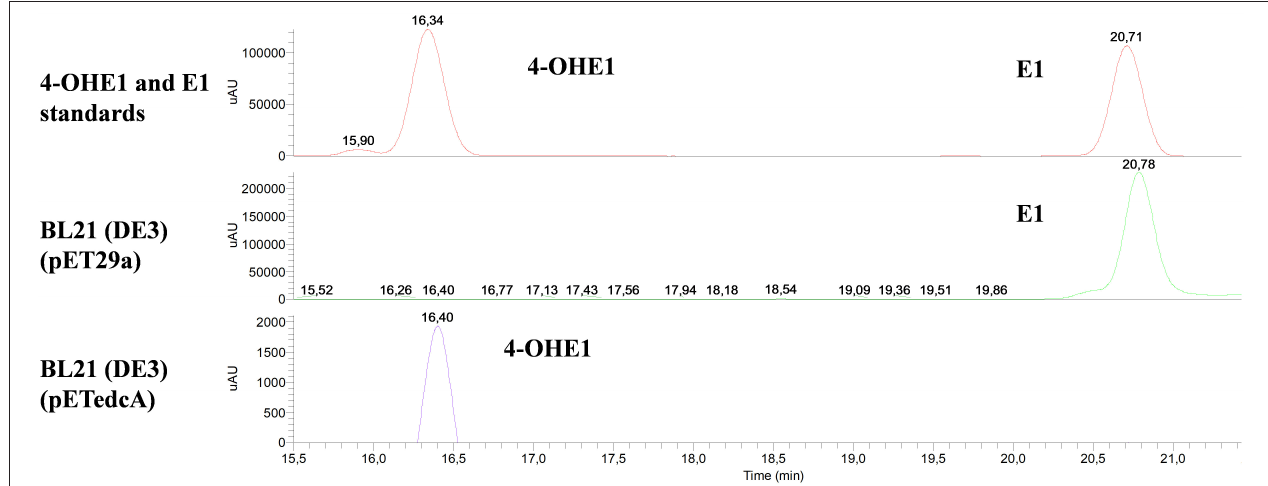
FIGURE 10 | HPLC-MS analysis of the organic phase extracted from the enzymatic assay using BL21 (DE3) (pETedcA) cell crude extract. UV chromatograms at 282nm of 4-OHE1 and E1 standards and the product from the enzymatic assay using BL21 (DE3) (pET29a) and BL21 (DE3) (pETedcA) cell crude extract.